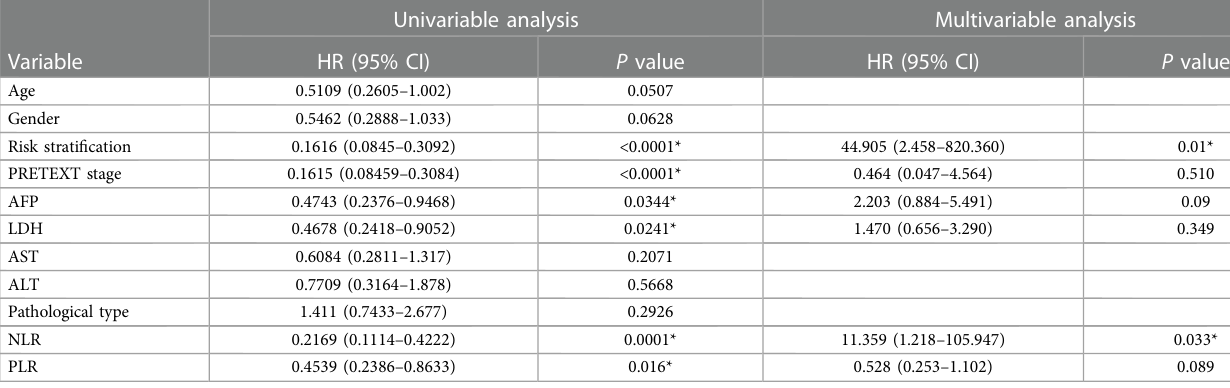
TABLE 4 Univariate and multivariate analyses of factors for the prediction of overall survival.